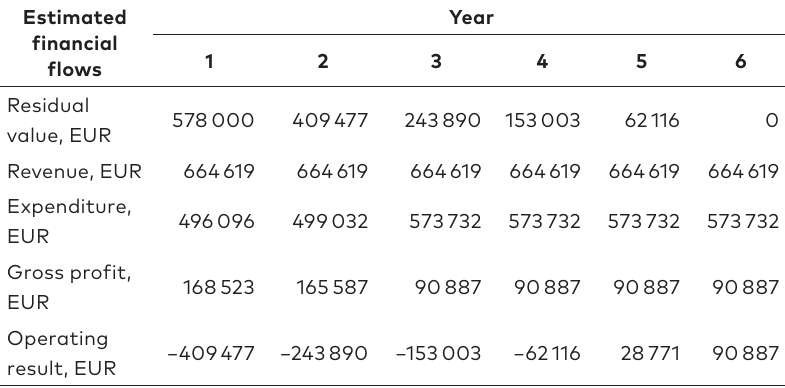
Table 4. Calculation of installation payback time in a pessimistic scenario